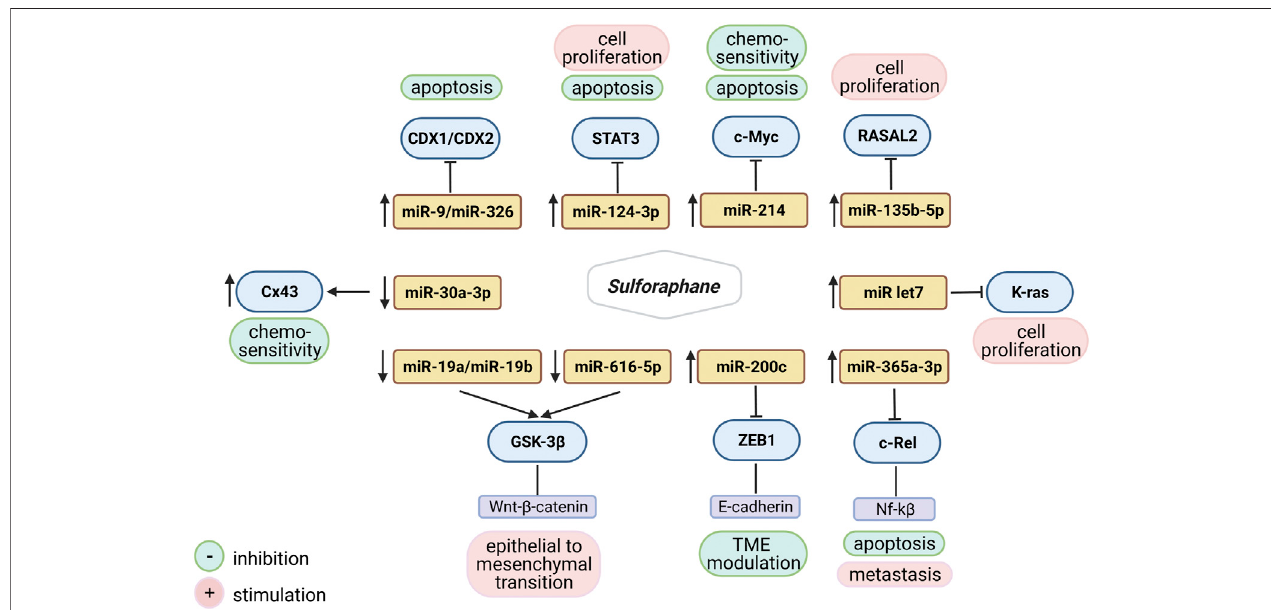
FIGURE 3 | The mechanism of action of sulforaphane by modulating expression of several miRNAs (yellow rectangles) which target speci fi c molecules (blue ovals) and/orpathways(purplerectangles),inducingtheobservedphenotypicalchanges – inducingofapoptosis,inhibitionofcellproliferation,inhibitionofmetastasis,inhibition of EMT, TME modulation and inducing of